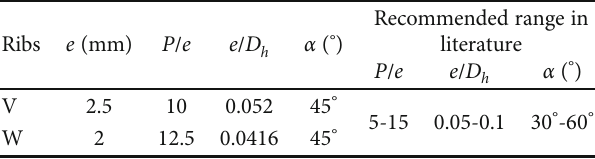
Table 1: Details of rib